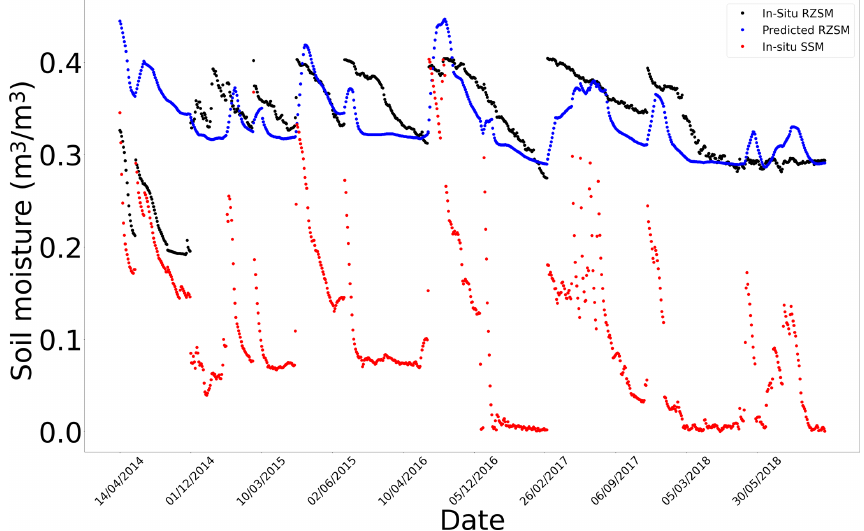
Figure F5. In situ SSM, in situ RZSM, and predicted RZSM series at station S-Coleambally with model ANN_SSM.